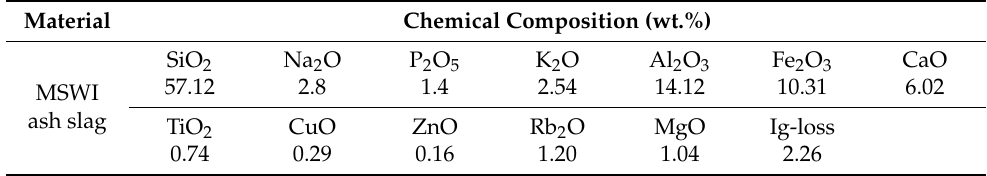
Table 1. Chemical composition of the MSWI ash slag used in this